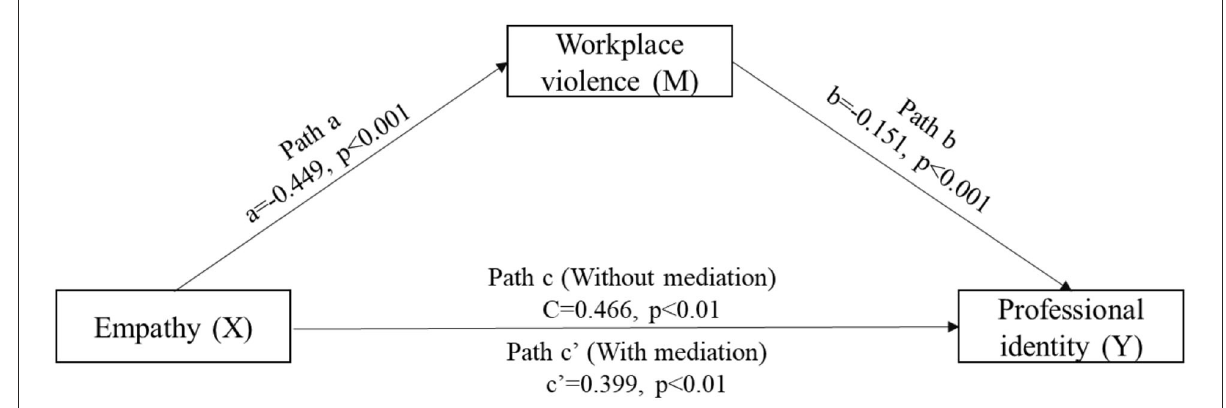
FIGURE2 Mediating role of workplace violence in the relationship between empathy and professional identity among nursing